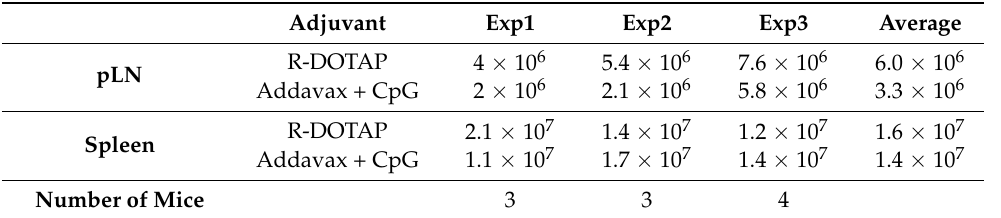
Table 3. Following subcutaneous vaccination with HA B/Malaysia in adjuvant and cytokine ELISpot using CD4 T cells isolated from the draining lymph node and spleen, as shown in Figure 3, the average frequencies of cytokine producing CD4 T cells per million corrected for background, the average number of cytokine-producing CD4 T cells per mouse corrected for background and fold differences between R-DOTAP and AddaVax+CpG were calculated.